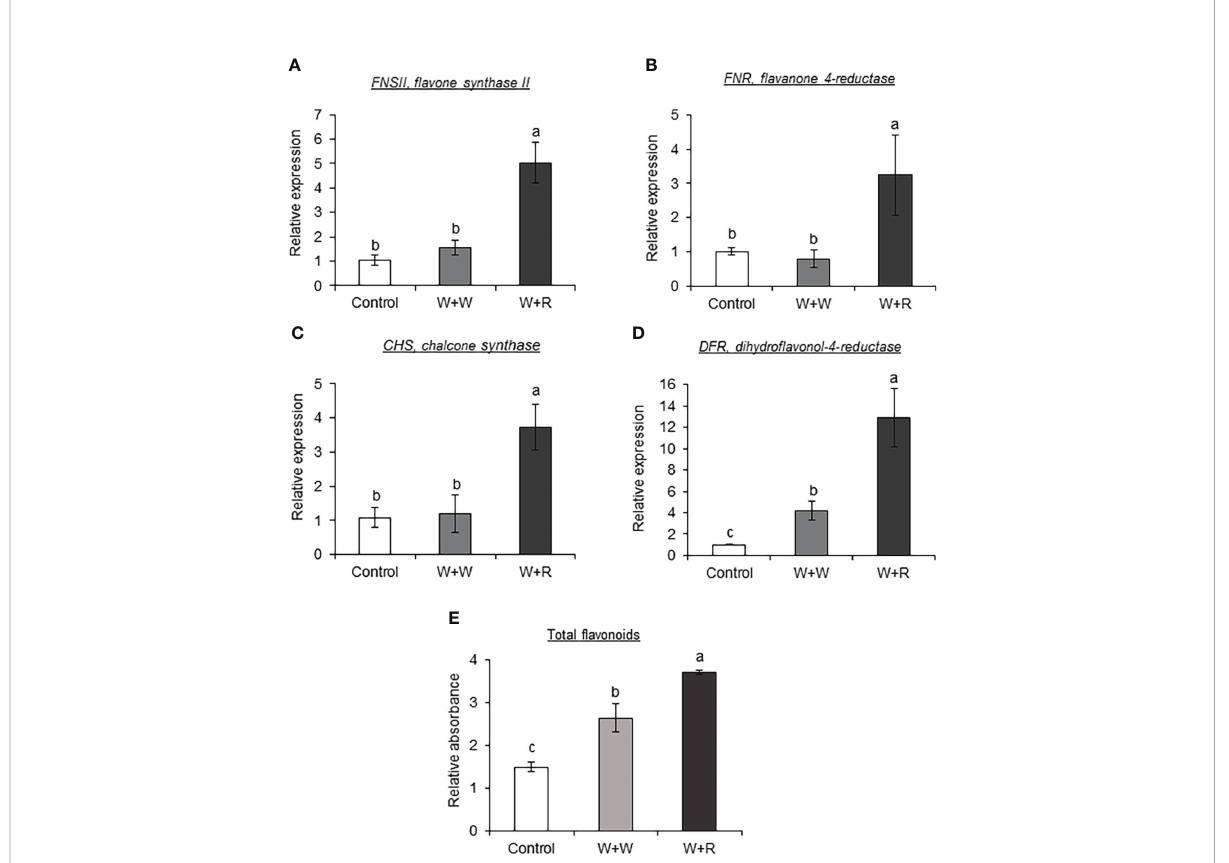
FIGURE 8 Application of fall armyworm (FAW) regurgitant on sorghum wounded plants enhanced the expression levels of fl avonoid pathway genes. RT- qPCR analysis of fl avonoid pathway genes (A) FNSII , fl avone synthase II; (B) FNR , fl avanone 4-reductase; (C) CHS , chalcone synthase; and (D) DFR3 , Dihydro fl avonol-4-reductase. (E) Total fl avonoids estimated using spectrophotometer in leaves of sorghum SC1345 plants after four applications of FAW regurgitant every 24 hours. Undamaged and wounded plants were used as controls (n = 3-4). Error bars represent ± SE. Different alphabets indicate signi fi cant difference relative to each other ( P < 0.05). W + W, treatments in which water was applied to wounds; W + R, treatments in which FAW regurgitant was applied to